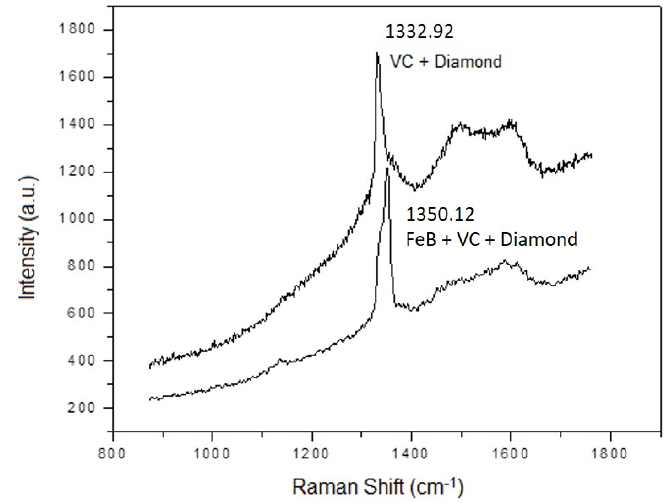
Figure 11. CVD diamond film Raman spectra (excitation with laser at 514.5 nm) on the steel substrate with thermal treatments of FeB + VC and VC.